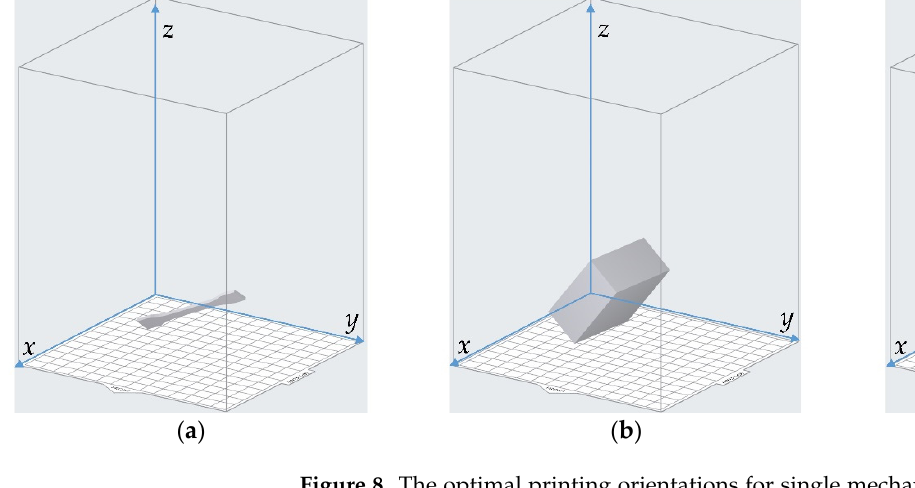
Figure 8. The optimal printing orientations for single mechanical properties in Preform software. ( a ) The optimal printing orientation for best tensile strength σ b ; ( b ) the optimal printing orientation for best compressive strength σ bc ; ( c ) the optimal printing orientation for best flexural modulus E .